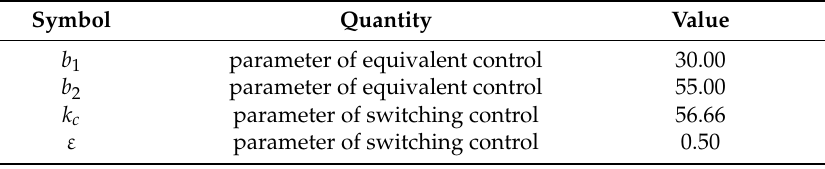
Table 4. Parameters of integral sliding mode controller.